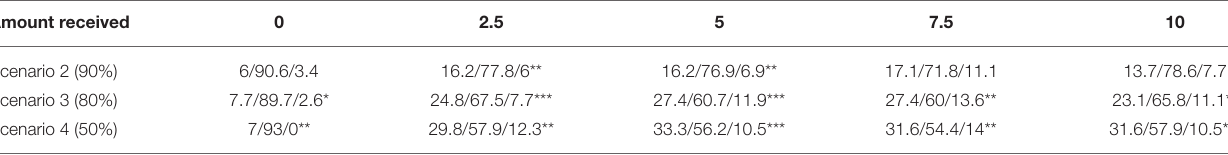
TABLE 3 | Pairwise comparison of reciprocating subjects’ back transfers.